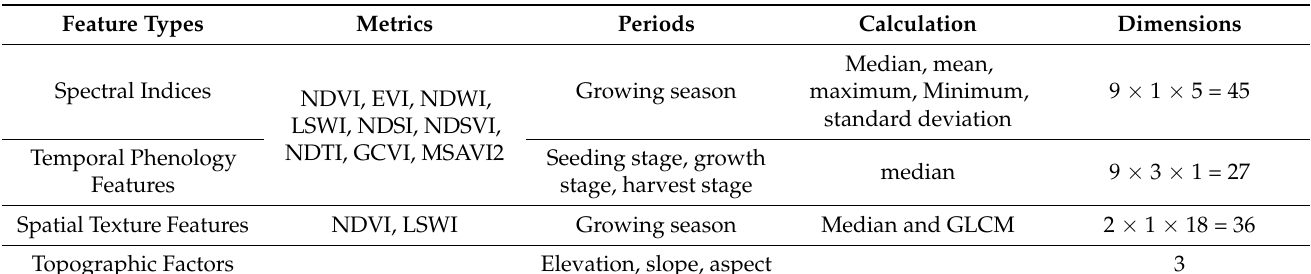
Table 1. Multi-dimensional RS features for crop type